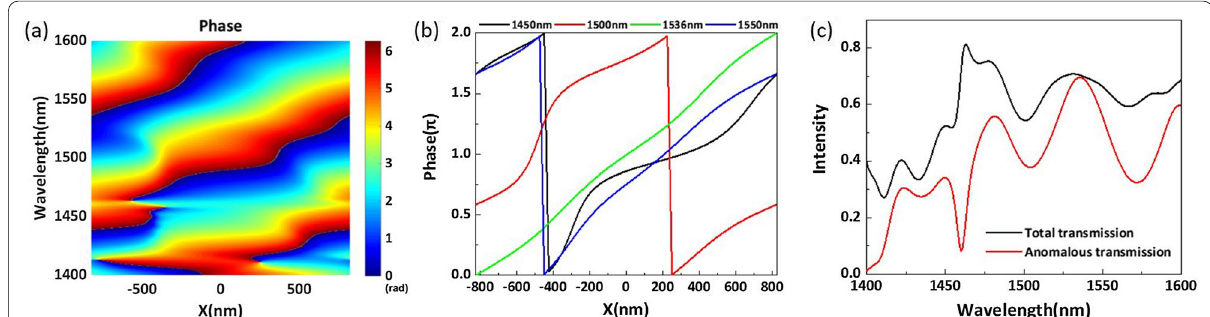
Fig. 9 a Simulated phase variation of the large angle metasurface along the x -direction in a complete period for wavelengths of 1400–1600 nm. b Full 2 π phase shift along the x -direction of the phase-gradient metasurface for 1450, 1500, 1536, and 1550 nm. c The intensity of the total transmission and anomalous